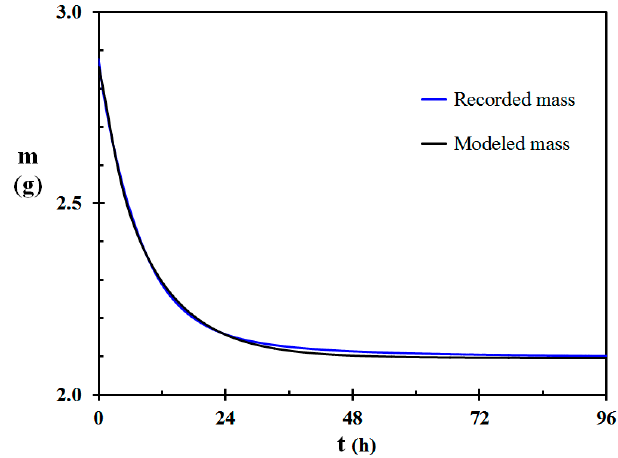
Figure 5. Recorded and modeled mass as a function of time for a 6.01 mm ( ± 0.11 mm) diameter Calluna test specimen.